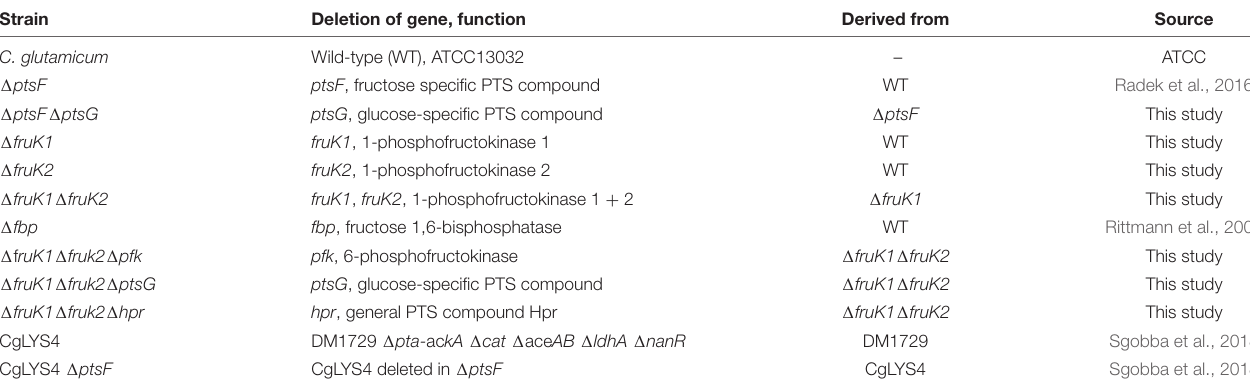
TABLE 1 | Corynebacterium glutamicum strains used in this study. Strain